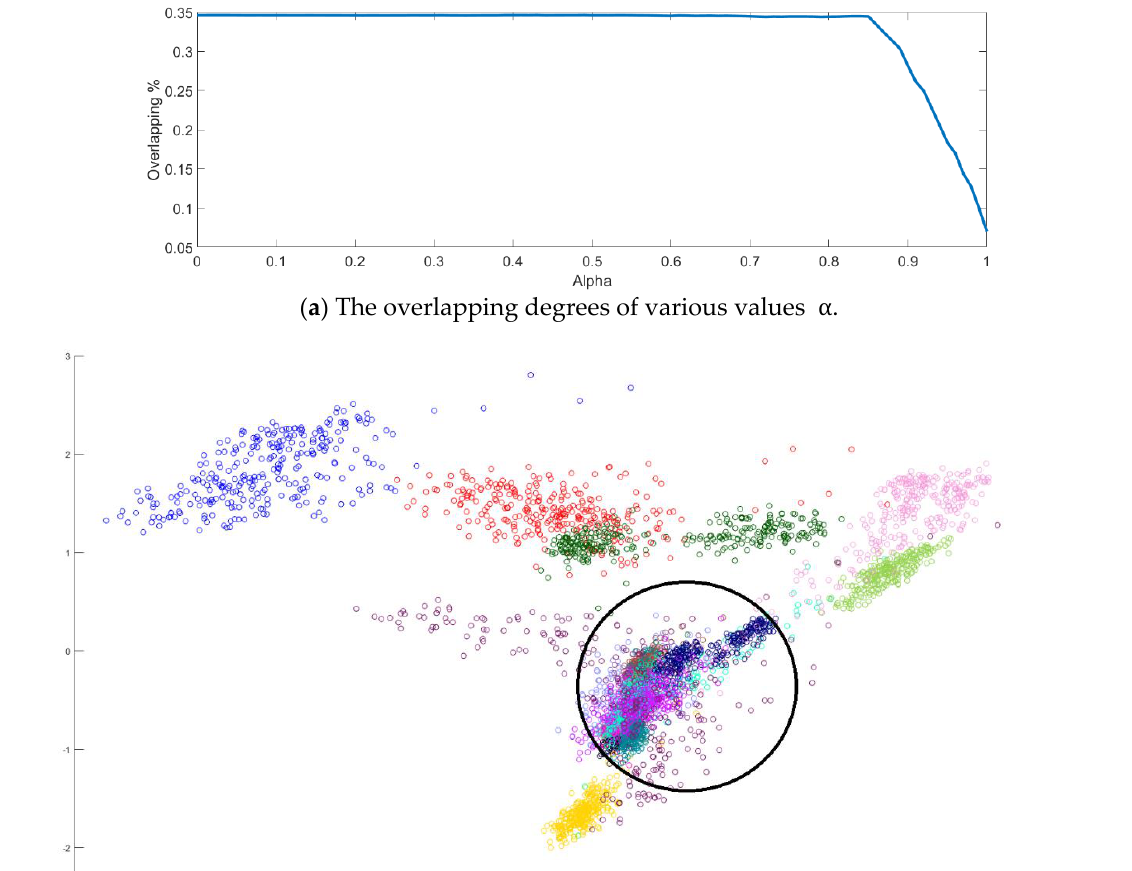
Figure 3. Dataset Salinas: ( a ) False color image; ( b ) Class label map.